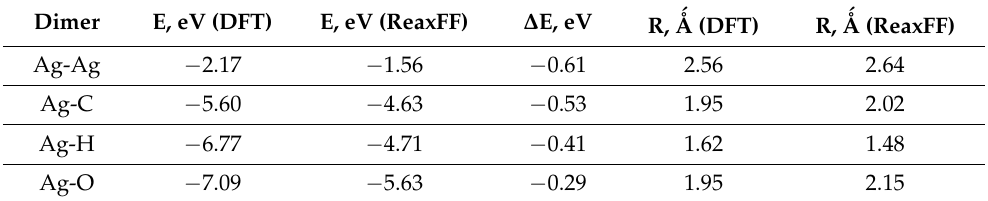
Table 4. Dimer binding energy calculated by DFT and ReaxFF, the energy difference between DFT and ReaxFF and bond length in